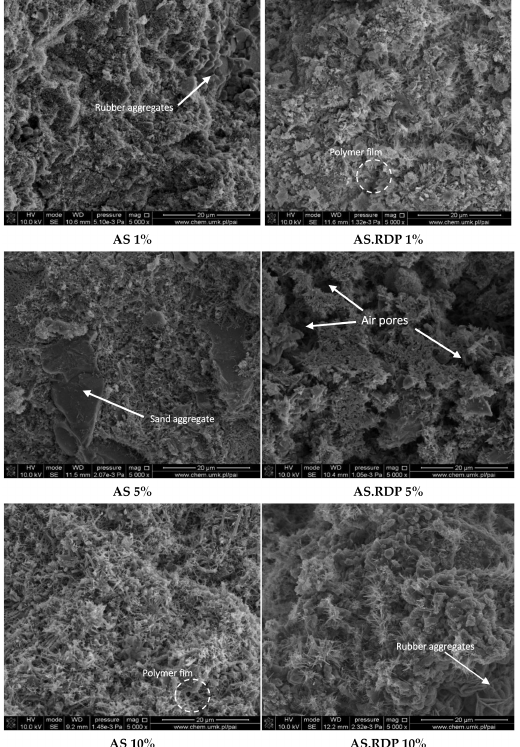
Figure 8. SEM microstructure of concrete with an addition of AS and AS.RDP (1%, 5%,